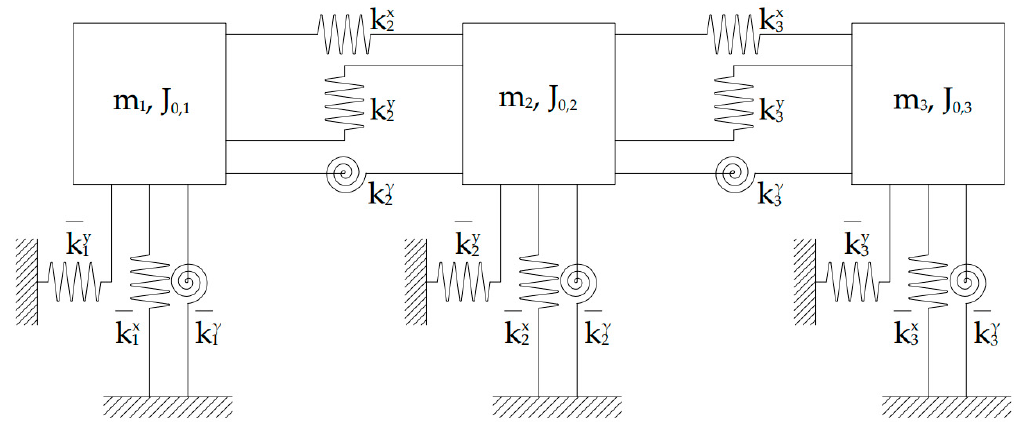
Figure 2. Lumped mass model of three adjacent interactive diaphragms.